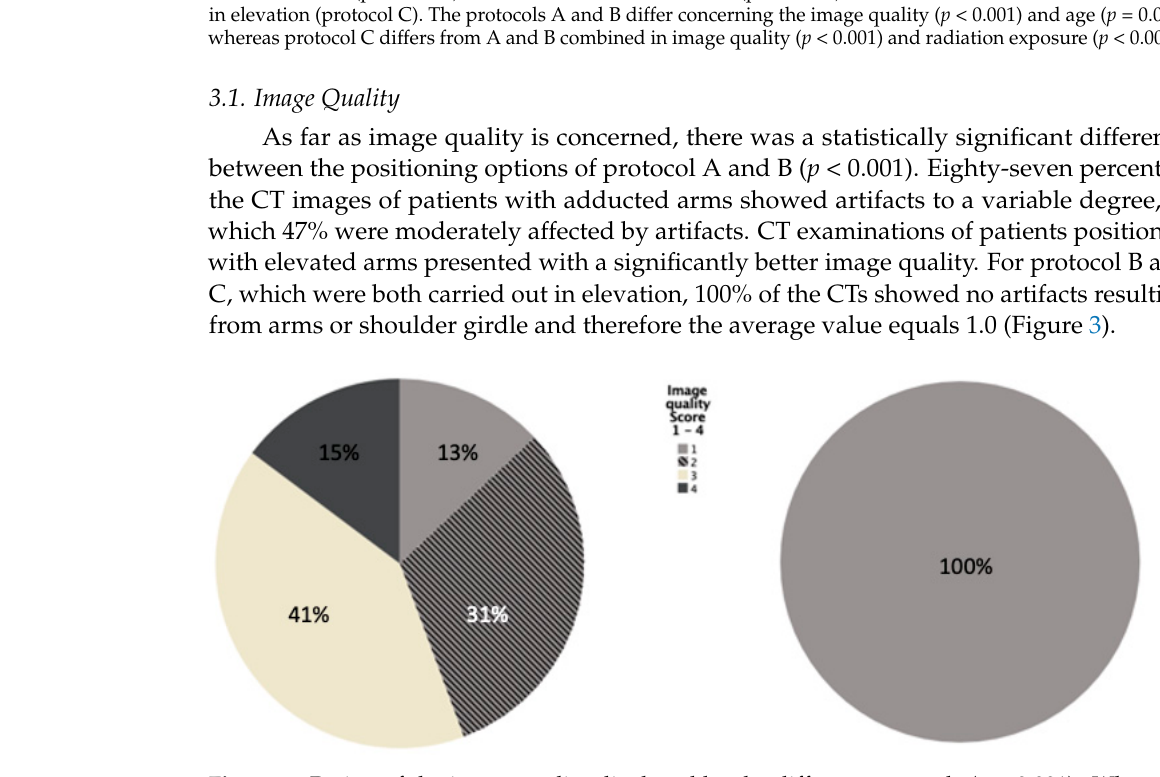
Figure 3. Rating of the image quality displayed by the different protocols ( p < 0.001). When the examination is carried out in elevation in the protocols B and C, no artifacts from the upper extremities occur and all images are rated with score 1.0 ( right ). When the arms are placed next to the abdomen in protocol A, artifacts occur to a variable degree ( left ). The extent of artifacts is represented in percentages by the different colors according to the legend included in the figure.